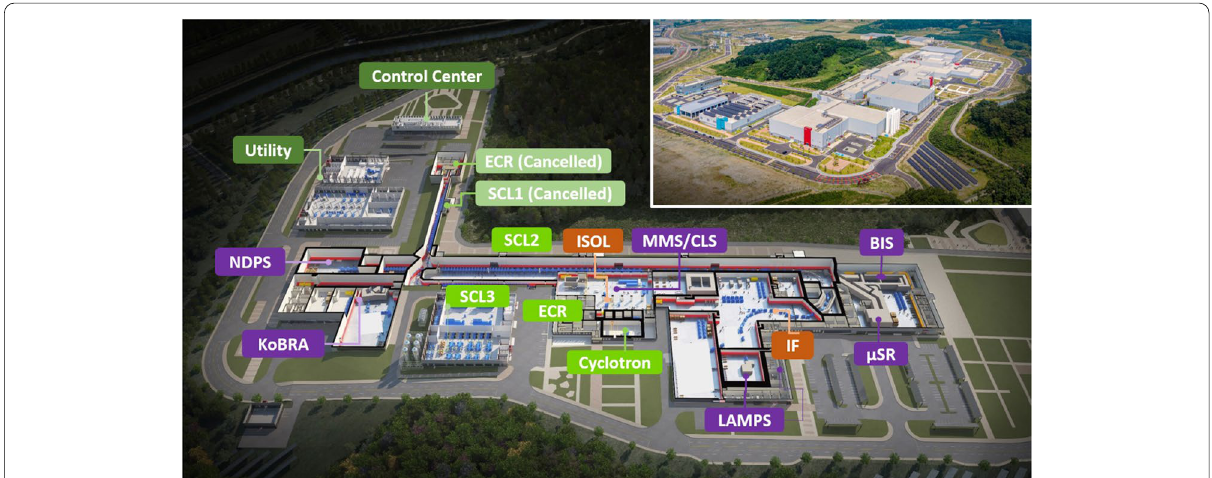
Fig. 1 Layout of the overall RAON facility. The items written in green and brown are the accelerator systems and RIB production systems, respectively. The items in purple are the experimental setups. One of the low-energy superconducting linac SCL1 and the associated ECRs were canceled because of the budget shortage, and the SCL3 and another set of ECRs play their role instead. The small panel in the upper-right corner